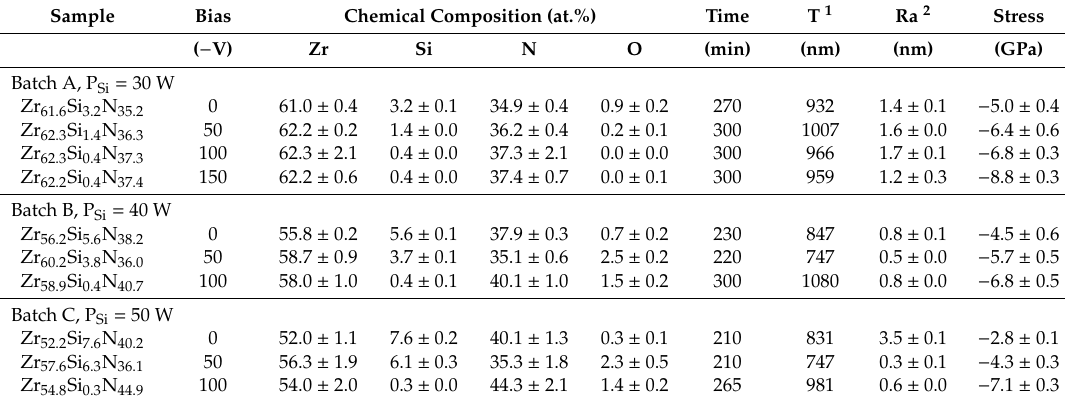
Table 1. Chemical composition, surface roughness, and residual stress of the Zr–Si–N films prepared with an average high-power impulse magnetron sputtering (HiPIMS) power of 300 W on Zr target and various RF powers on Si target at various bias voltages. Sample Bias Chemical Composition (at.%) Time T